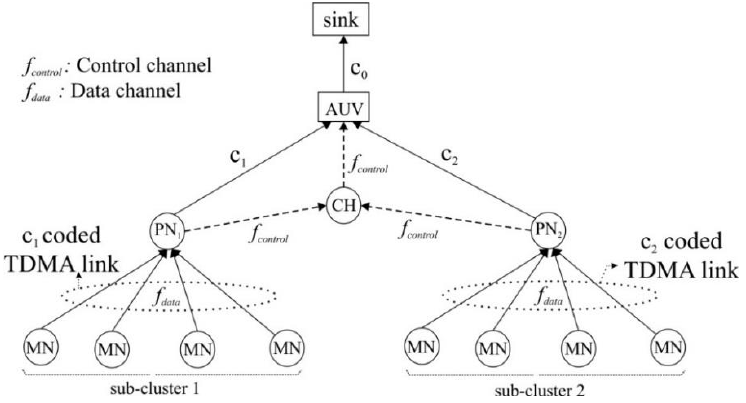
Figure 2. Medium-access